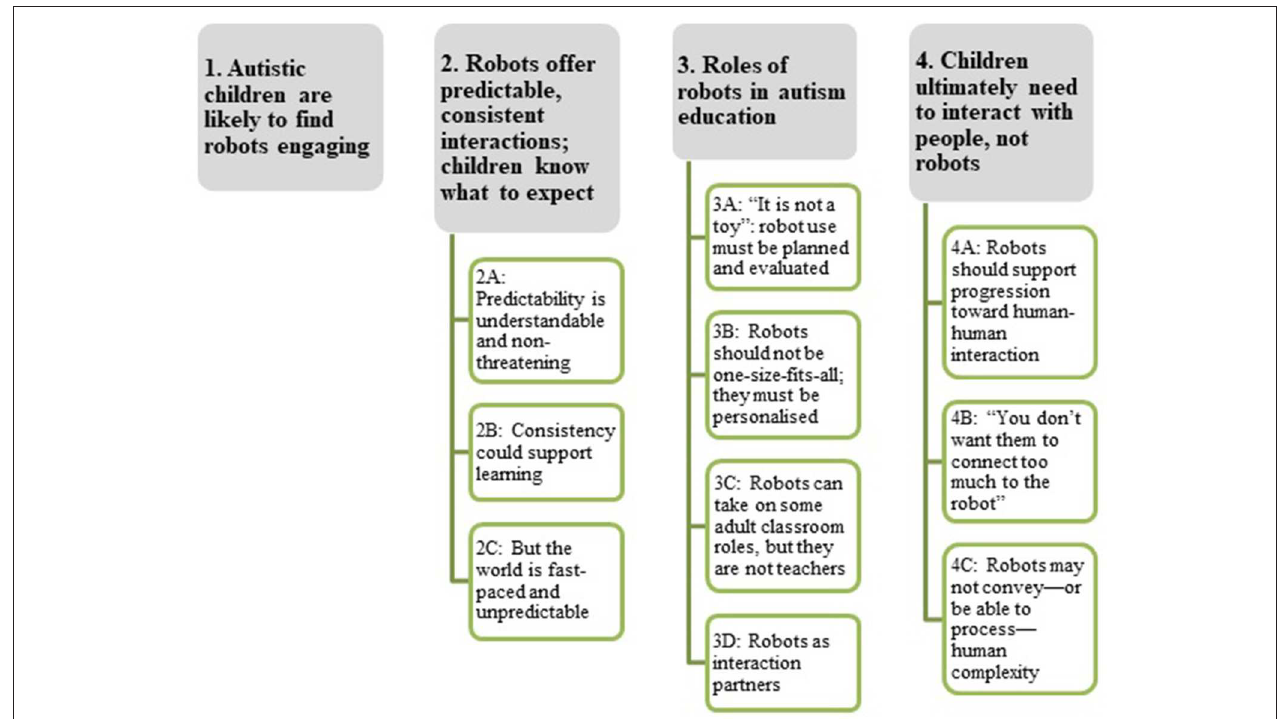
FIGURE 1 | Summary of themes and